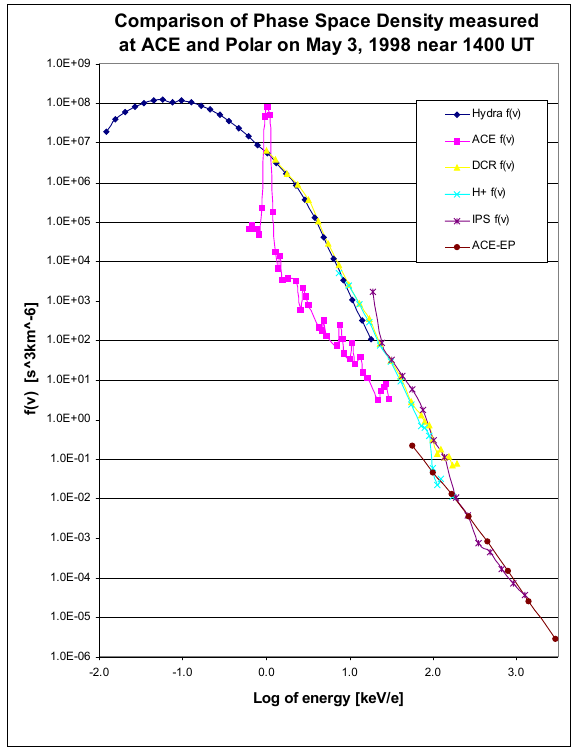
Fig. 9. Same format as Fig. 2 but now the two populations corre- spond to a plasma with an average Fe charge state of +8 recorded just before 02:00UT on 2 May at ACE and just after 02:00UT at Polar.